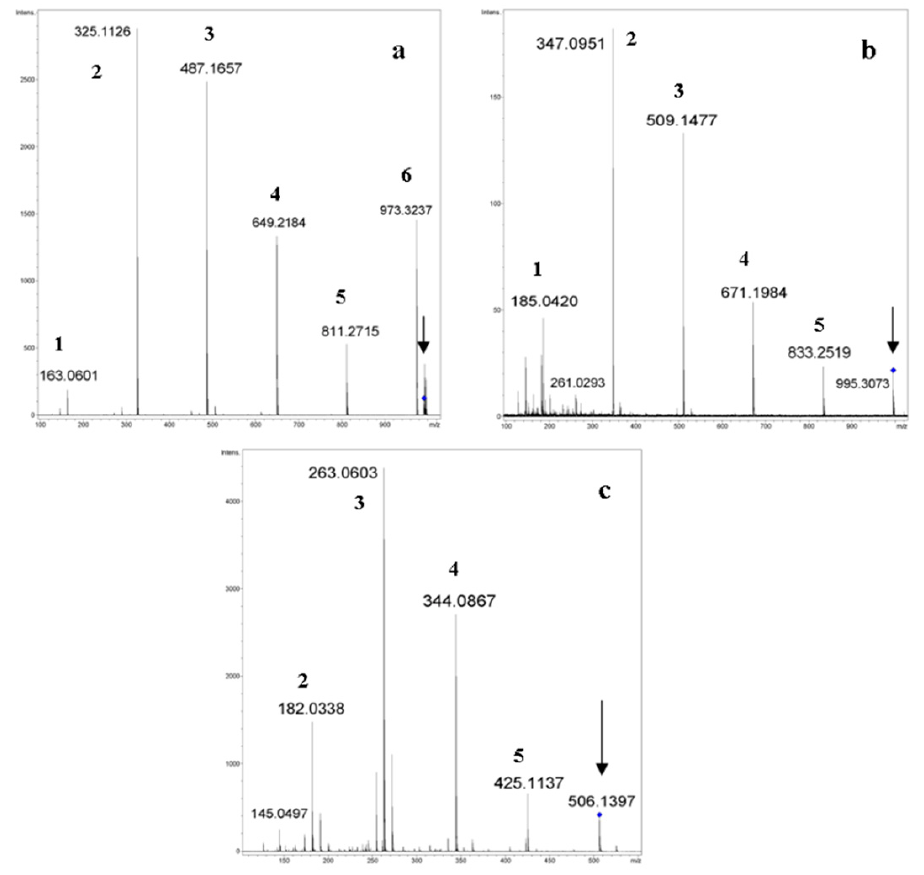
Figure 4. Tandem (CID MS 2 ), high-resolution ESI mass spectra of selected ions generated from α -CD (the authors’ data). Fragmented ions (marked by arrows): a . [M + NH 4 ] + , m / z 990, c.e. 15 eV, b . [M + Na] + , m / z 995, c.e. 65 eV, c . [M + H + K] 2+ , m / z 506, c.e. 20 eV. The numbers mean the amount of Glc